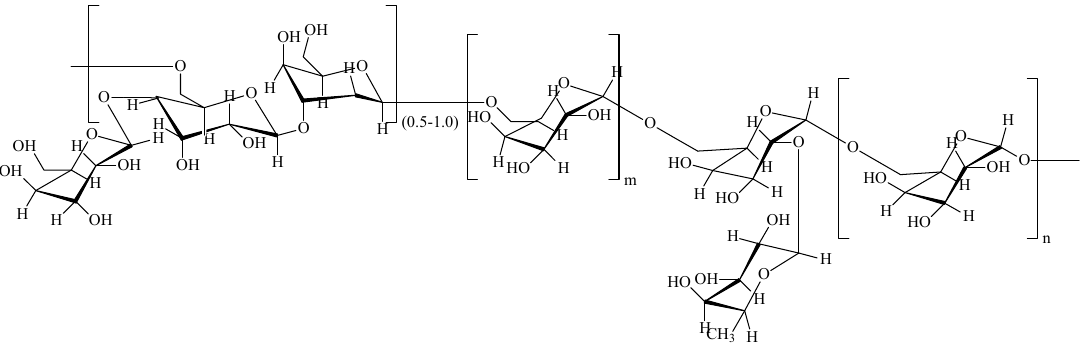
Figure 1. Three-dimensional chemical structure of the polysaccharides-proteoglycan repeating units- extracted from Ganoderma lucidum . The major polysaccharides identified in the G. lucidum bodies showed to have a backbone of β -(1 → 3)-linked D-glucopyranosyl residues, with branches of mono-, di- and oligosaccharide side chains substituting at the C-6 of the glucosyl residues in the main chain.